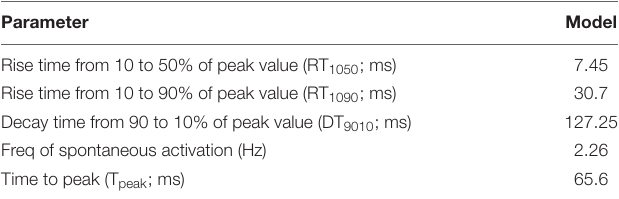
TABLE 5 | Intracellular calcium transient parameters in our model during spontaneous